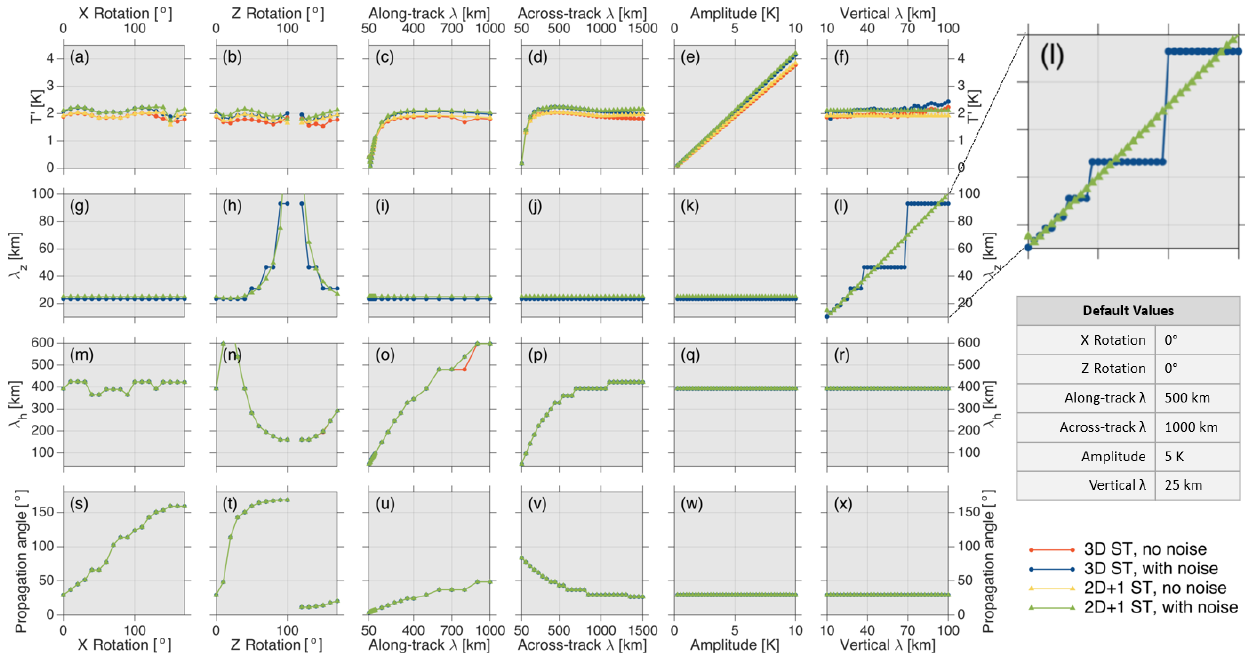
Figure 4. Systematic comparison of the 3D ST and 2D + 1 ST for a wide range of input artificial waves. Each panel shows recovered (a–f) wave amplitude, (g–l) λ z , (m–r) λ h and (s–x) propagation angle for the four different analyses indicated at bottom right. For each panel, the parameter named at the top and bottom of the column is varied systematically, with all other parameters set to the default values shown in the table at the top right. Note that, in many cases, the results for each method are identical, and for these only the last plotted (2D + 1 ST with noise) analysis is visible. Panel (l) is the only test to exhibit significantly different results between the 3D ST and 2D + 1 ST and is shown as a magnified inset at the top